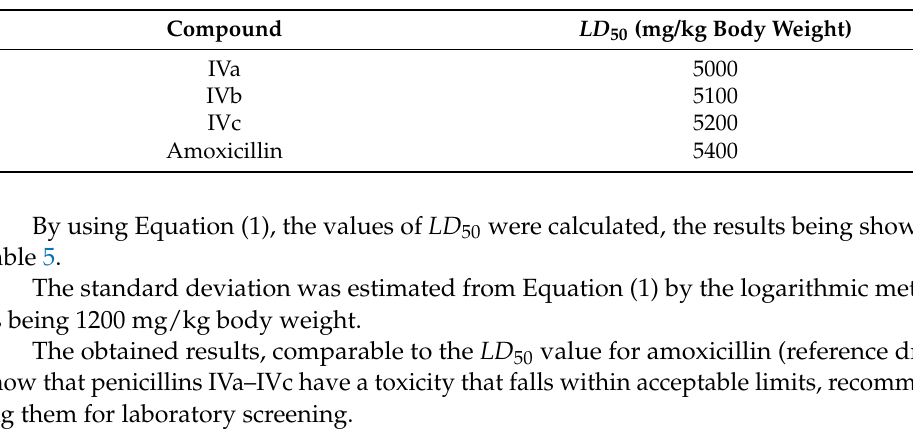
Table 5. LD 50 values for penicillins IVa—IVc and amoxicillin as reference